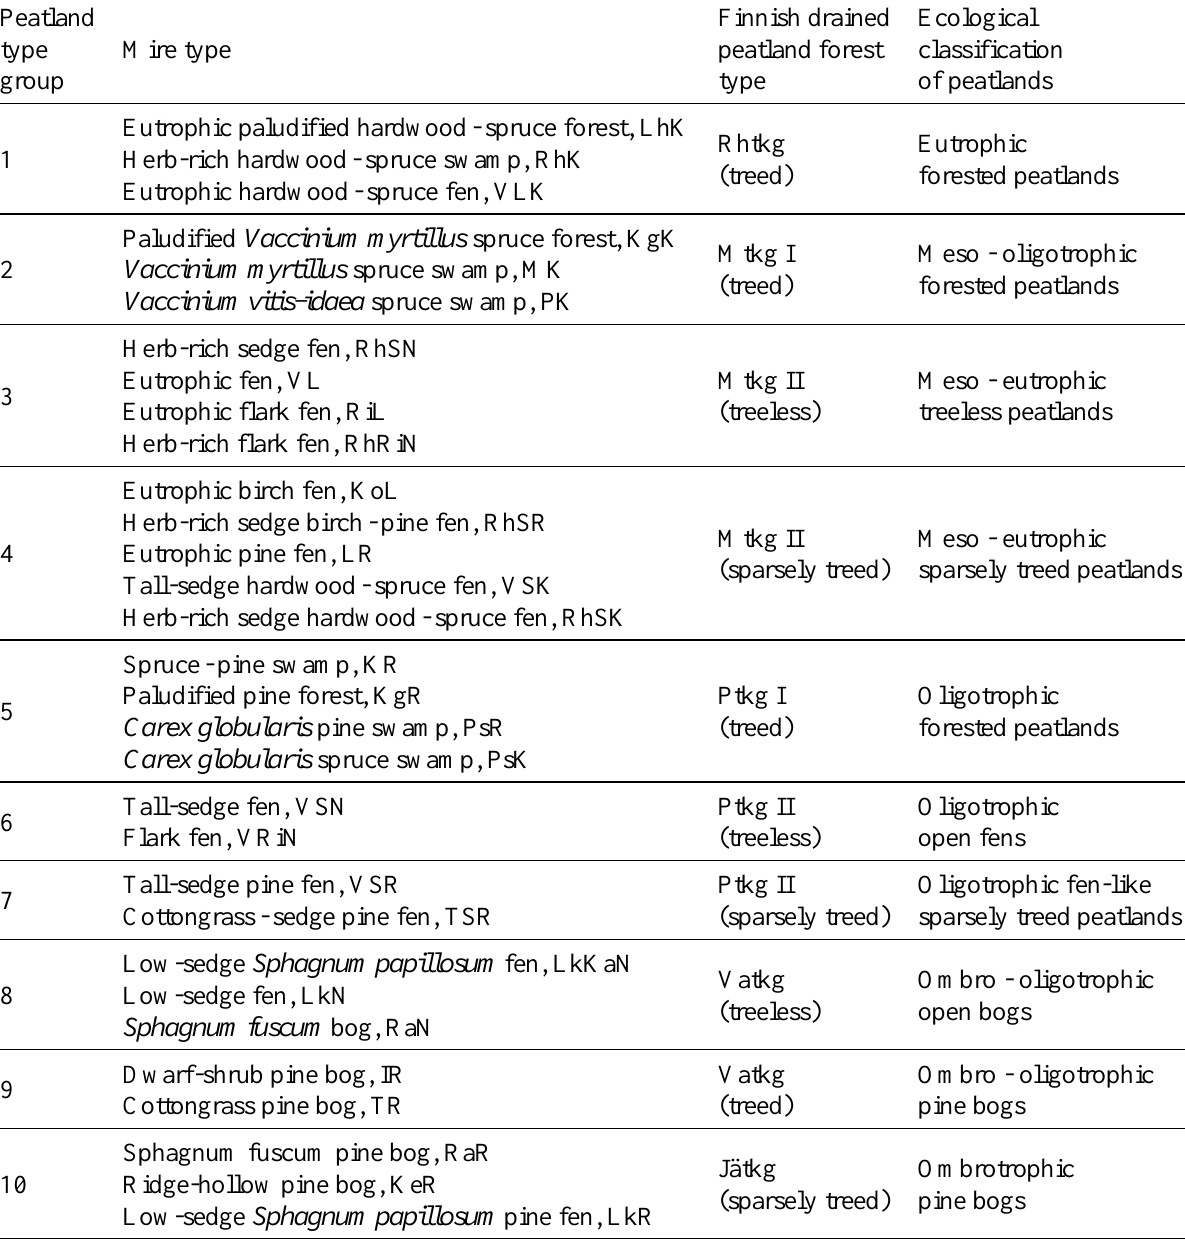
Table 1. The peatland type groups. The classification is based on Minkkinen (1999) and Turunen et al. (2002). The original (undrained) site types are paired with the drained site types into which they develop following drainage (Laine